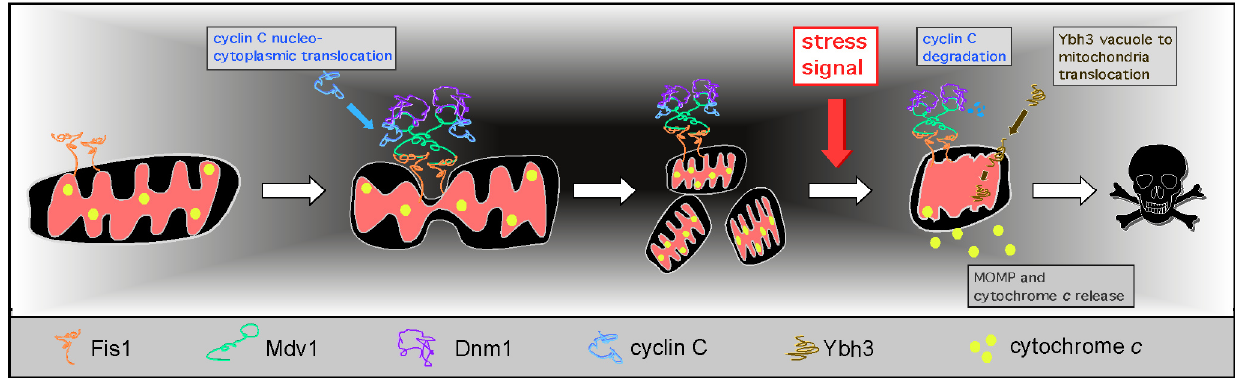
FIGURE 3: Cyclin C regulation of mitochondrial morphology and PCD following ROS stress. Upon release from the mediator complex, cyclin C enters the cytoplasm where it associates with Mdv1 promoting Mdv1-Dnm1 complex formation and extensive mitochondrial fragmentation. Thereafter, cyclin C disassociates from the fission complex and is destroyed by ubiquitin-mediated degradation. An additional stress signal, in combination with hyper-fission and Ybh3 localization to the mitochondria, is needed to complete the PCD pathway (represented by MOMP and cytochrome c